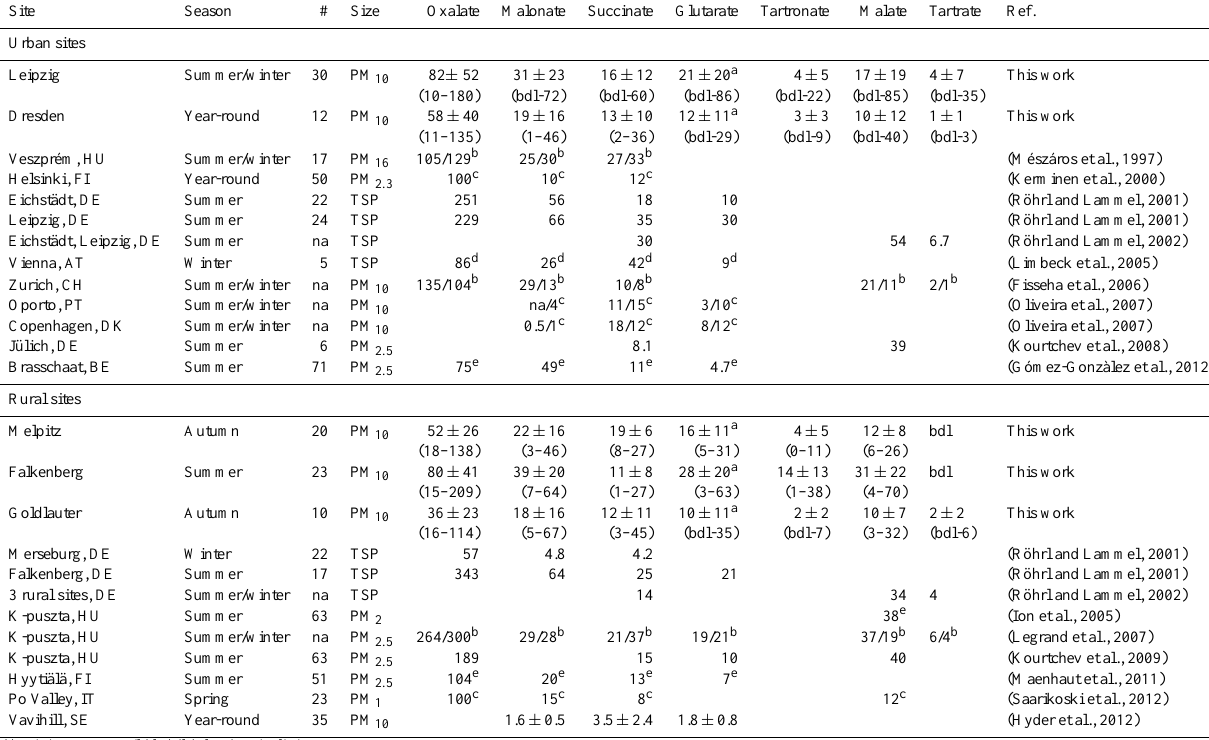
Table 1. Concentrations of DCAs determined in this work and literature data from comparable European rural and urban sites. All data given in ngm − 3 as mean ± standard deviation (min–max). For Melpitz, Falkenberg and Goldlauter data mean and standard deviation were calculated in a weighted manner to account for the variable sampling times applied at these